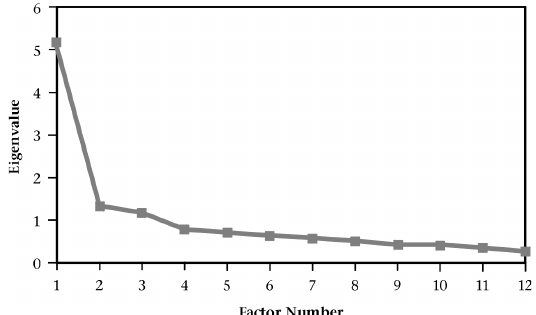
Figure 1:Eigenvalues for the Hearing Protection Survey From the Plot of the Eigenvalues in Figure 1 above, it would appear that the extraction of three factors are indicated since three factors have eigenvalues larger than 1,0 and the “scree” (line plot levels off) appears to begin at factor